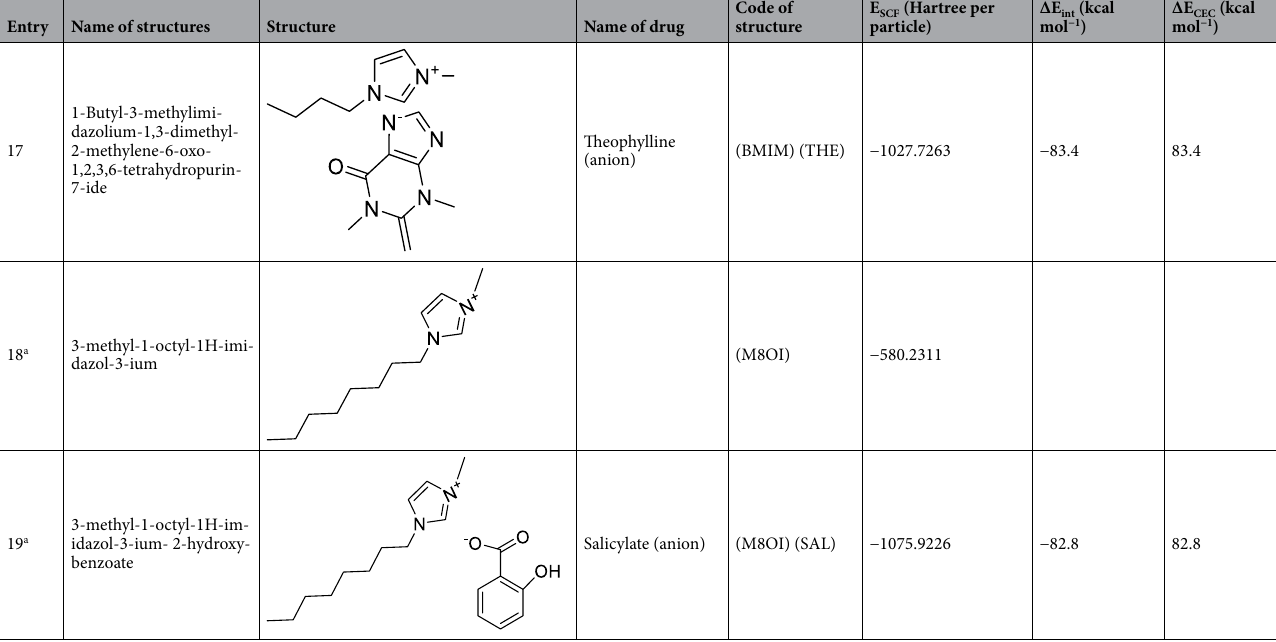
Table 1. ΔE int and ΔE CEC (kcal.mol -1 ) for the ionic liquids based on BMIM, calculated at the B3LYP/6- 311++G(d,p) level. (a) Entries 18 and 19 were added to Table 1, to compare the effects of the alkyl chain